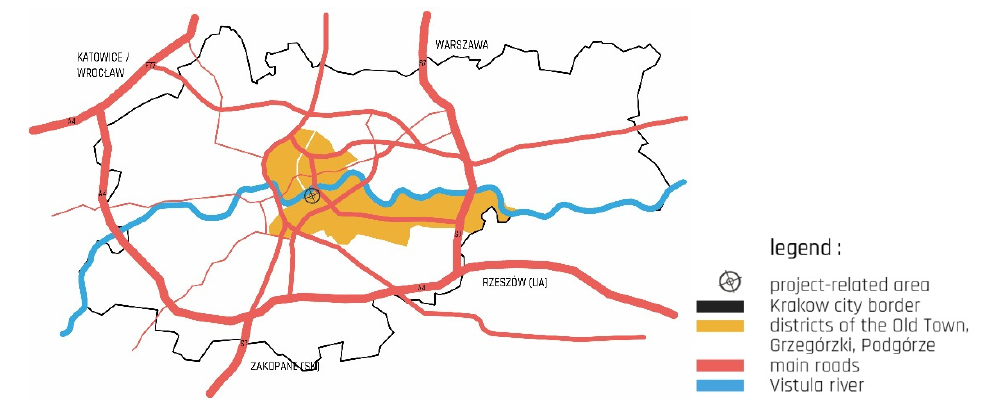
Figure 6. Main arterial roads of Cracow (Kraków), (elaborated by E. Latusek).